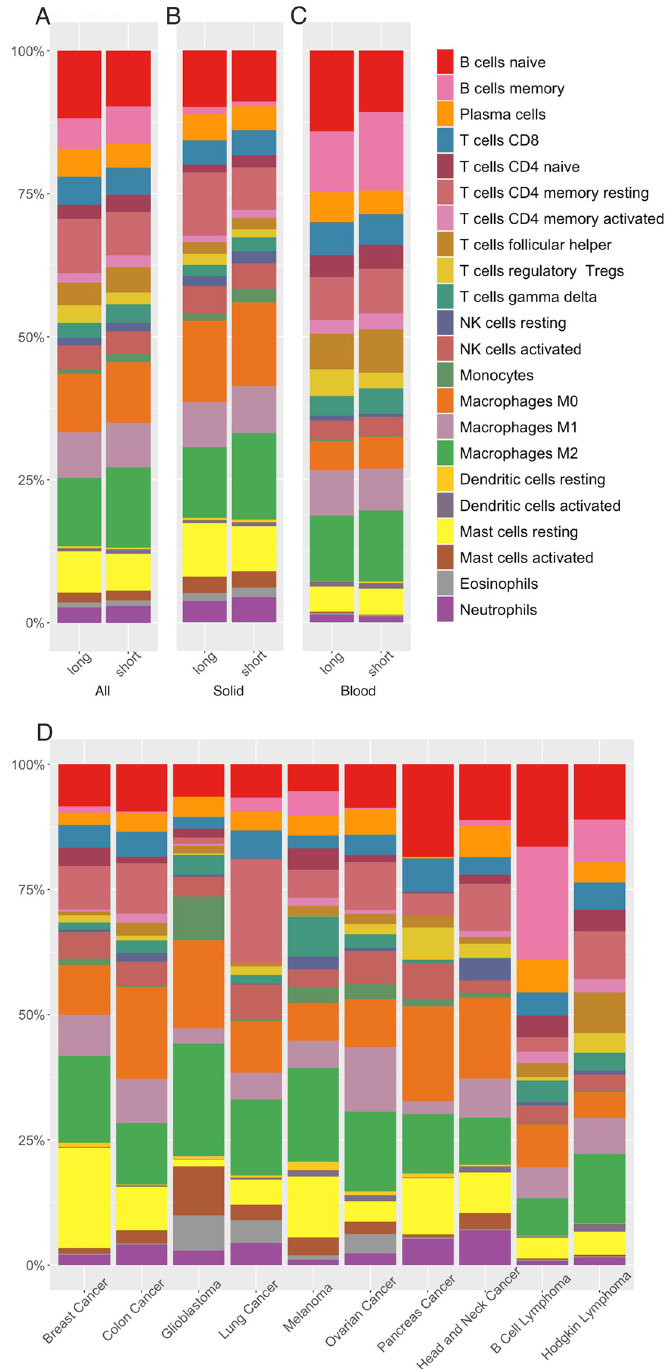
Fig 9. Estimation of immune cell composition in 515 cancer patients using CIBERSORT. Stacked bar plots in panels A, B and C show the CIBERSORT-derived immune profile of long versus short survival comparison of all, solid and blood cancer patients, respectively. Stacked bar plots in panel D show the immune profile of each cancer type under investigation. Different colours in bar plots represent different immune cell types according to the legend provided. The y-axis shows relative percentages of the cell types whereas the x-axis shows survival (long versus short) (panels A-C) or cancer types (panel D).